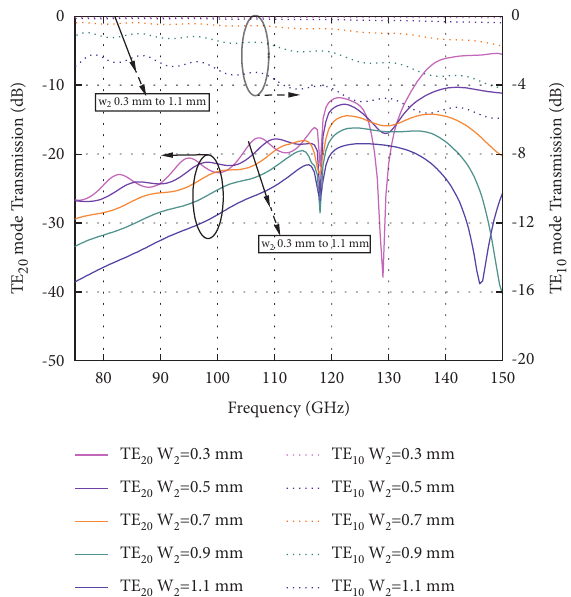
Figure 8: Simulated transmission coefficients of TE10 mode and TE20 mode for slot width w2 � 0.3, 0.5, 0.7, 0.9, and 1.1